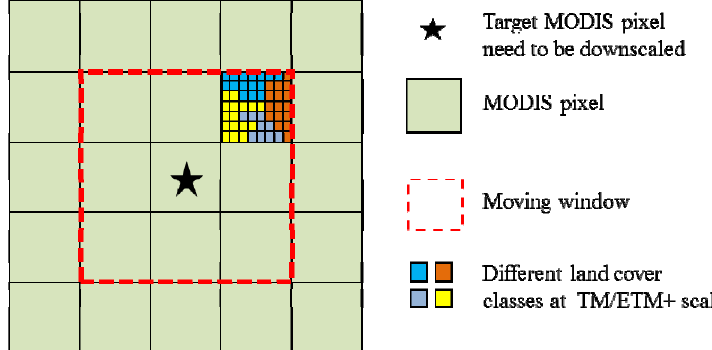
Figure 3. The spatially neighboring pixels of a target MODIS pixel in a moving window and land cover composition in a MODIS pixel classified from available TM/ETM+